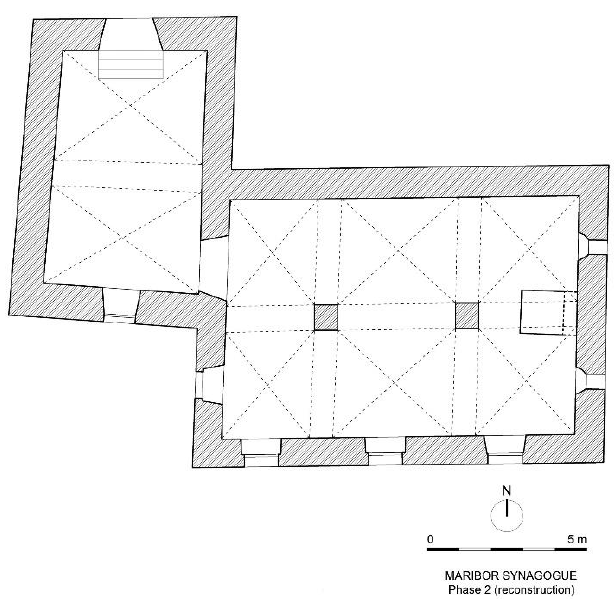
Figure 17. Ground plan of the second synagogue phase. Architectural drawing: Nejc Bernik, based on a template by Anja Premk.